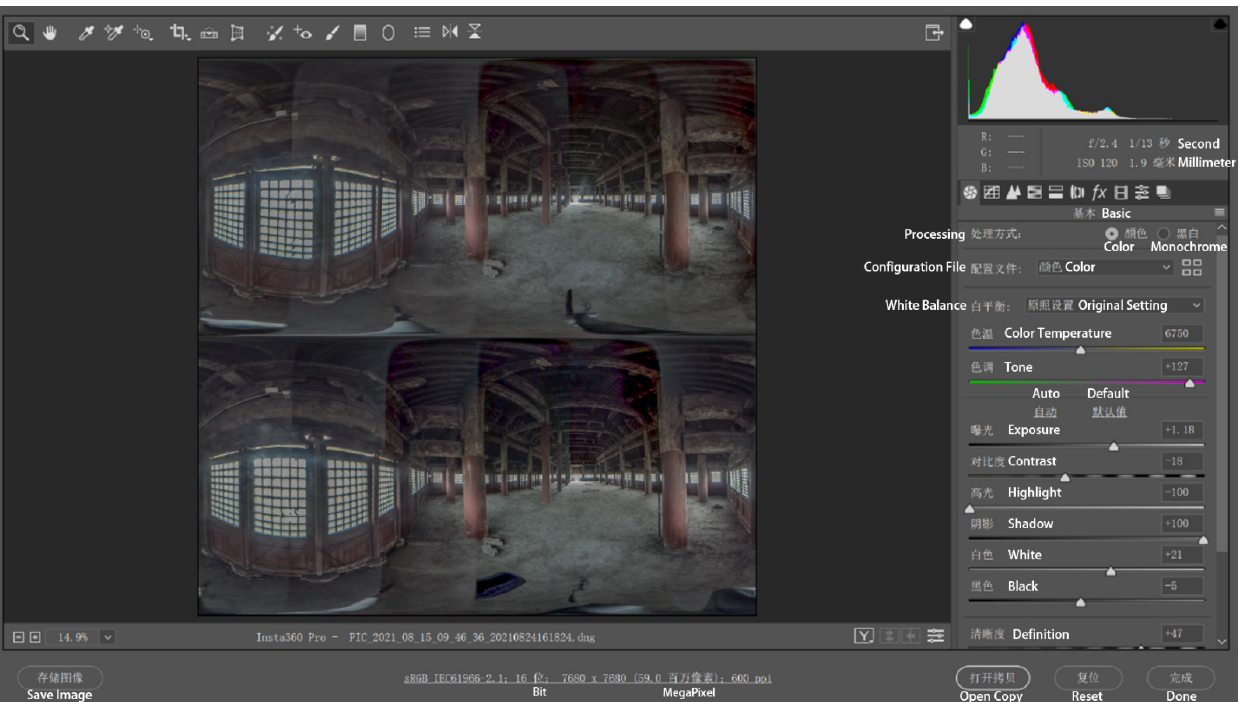
Figure 5. Post-processing a 3D panorama photo of the second floor in the study site in Camera Raw.